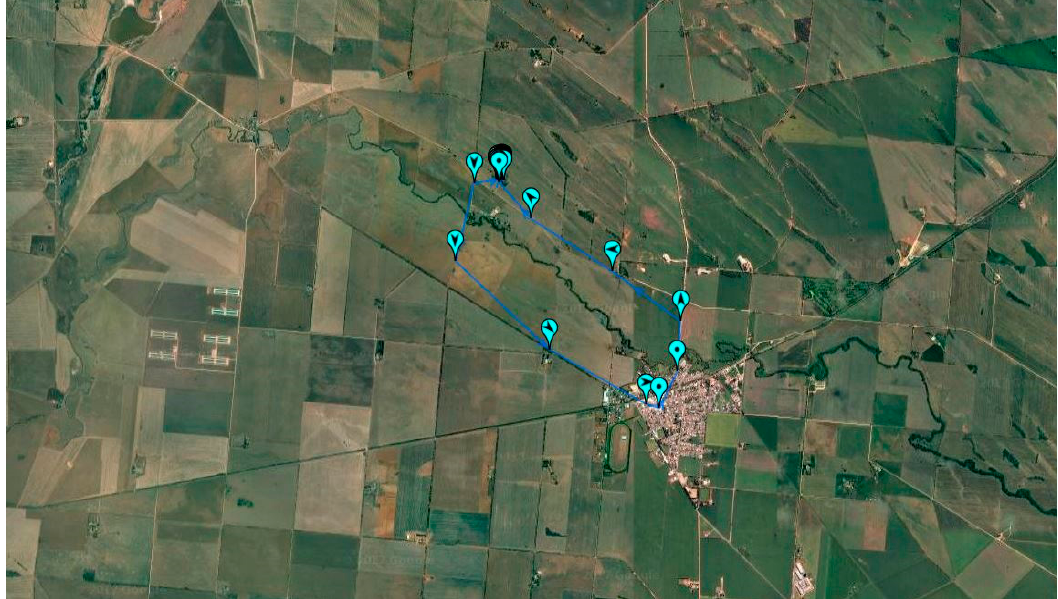
Figure 3. Global positioning systemmap of participant walk in the country.